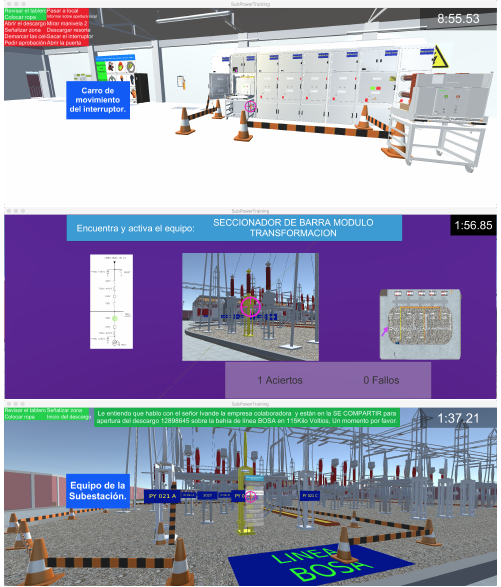
Figure 7. Three different missions can be performed. The top image shows indoor medium-voltage switchgear maintenance on an outgoing feeder including CB switching operation and CB withdrawal and reconnection after maintenance. The middle image shows outdoor yard equipment recognition according to one-line diagram. The bottom image shows an HV switchgear bay local operation of non-load